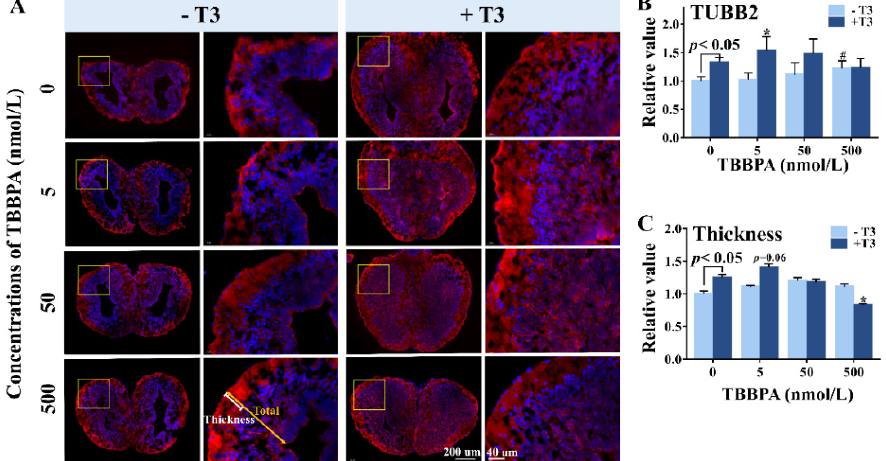
Figure 5. The effect of TBBPA on neurodifferentiation in the brain of NF stage 52 Xenopus laevis tadpoles exposed to a series of concentrations of TBBPA in the absence or presence of 1 nmol/L T3. ( A ) the immunofluorescence images of telencephalons retained TUBB2 (red) and DAPI (blue). ( B ) the relative fluorescence intensity of TUBB2, normalized by the control group. ( C ) The relative thickness of the outer neuropil. The data were normalized by the mean value of the solvent control. Data are shown as mean ± SD. # indicates significant differences between TBBPA treatment and solvent control treatment ( p < 0.05). * indicates significant differences between TBBPA + T3 treatment and T3 treatment ( p < 0.05). The experiment was repeated three times using tadpoles from different sets of adults. The results were consistent among the three independent experiments.